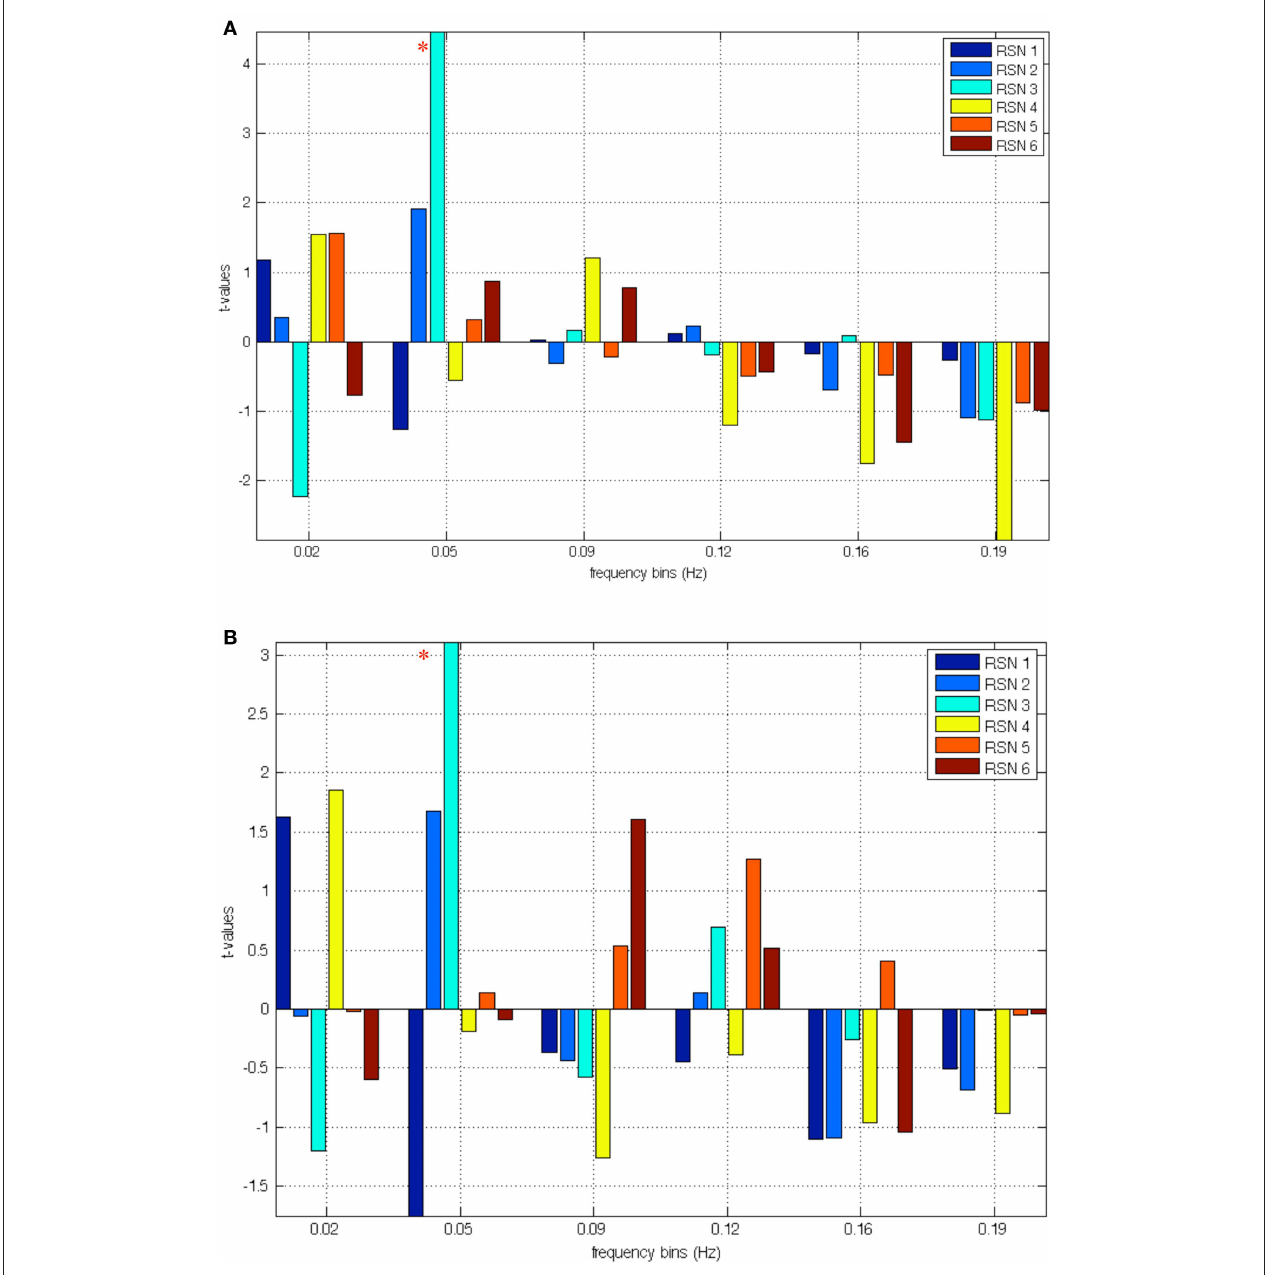
FIguRe 2 | (A) Correlation between relevant RSNs frequency bins and scores at the positive factor; the red asterisk indicates significant correlations with RSN 3 (VN). (B) Correlation between relevant RSNs frequency bins and scores at the negative factor; the red asterisk indicates correlations with RSN 3 (VN). ( Continued